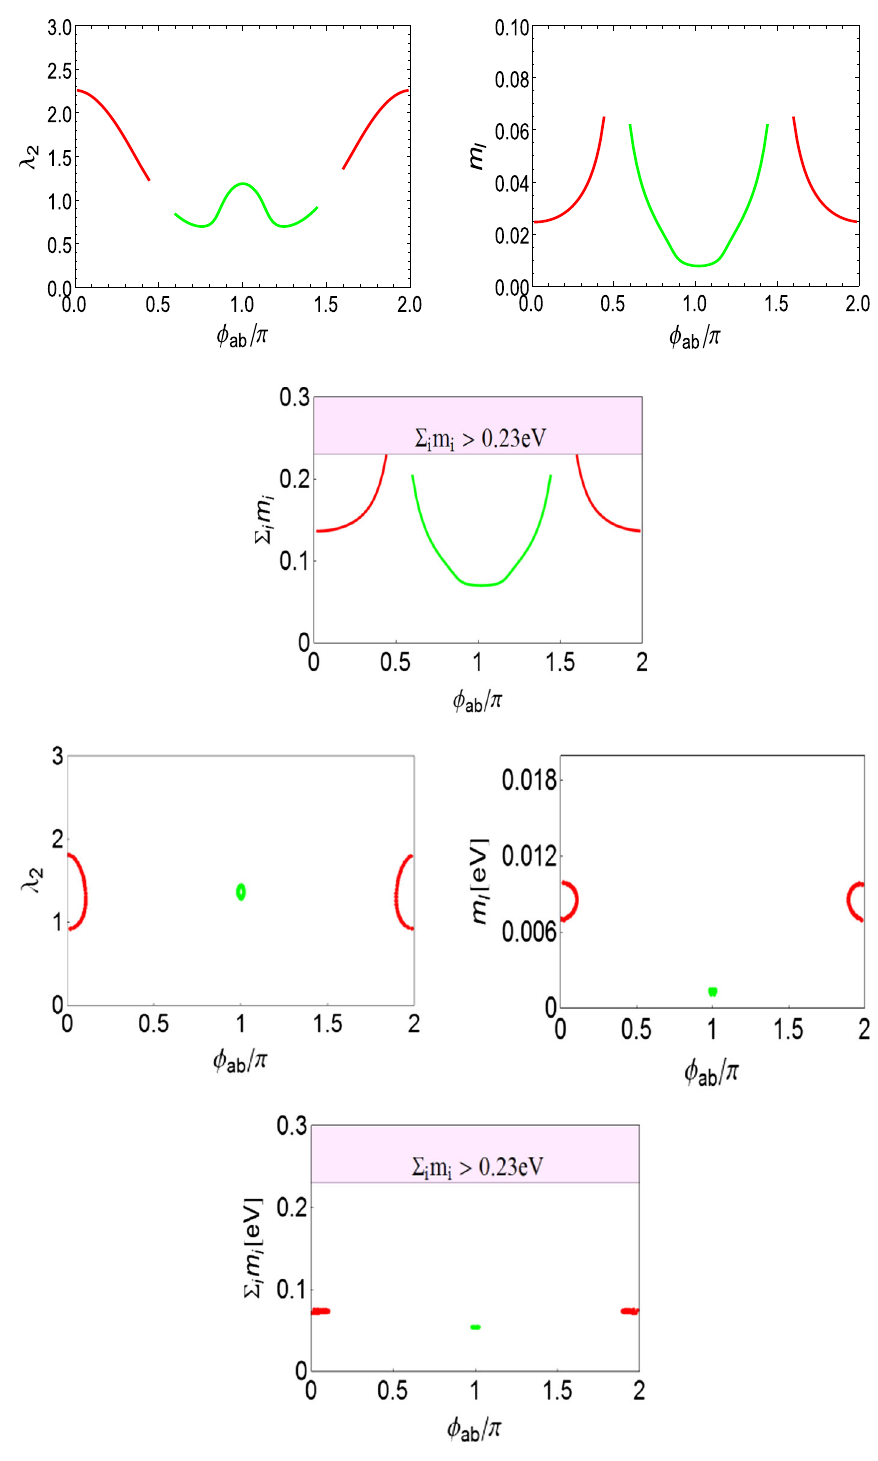
Fig. 1 Variation of λ 2 , the lightest neutrino mass ( m l ) and (cid:4) φ i m i with ab , red lines are for the inverted hierarchy and green lines are for the normal hierarchy